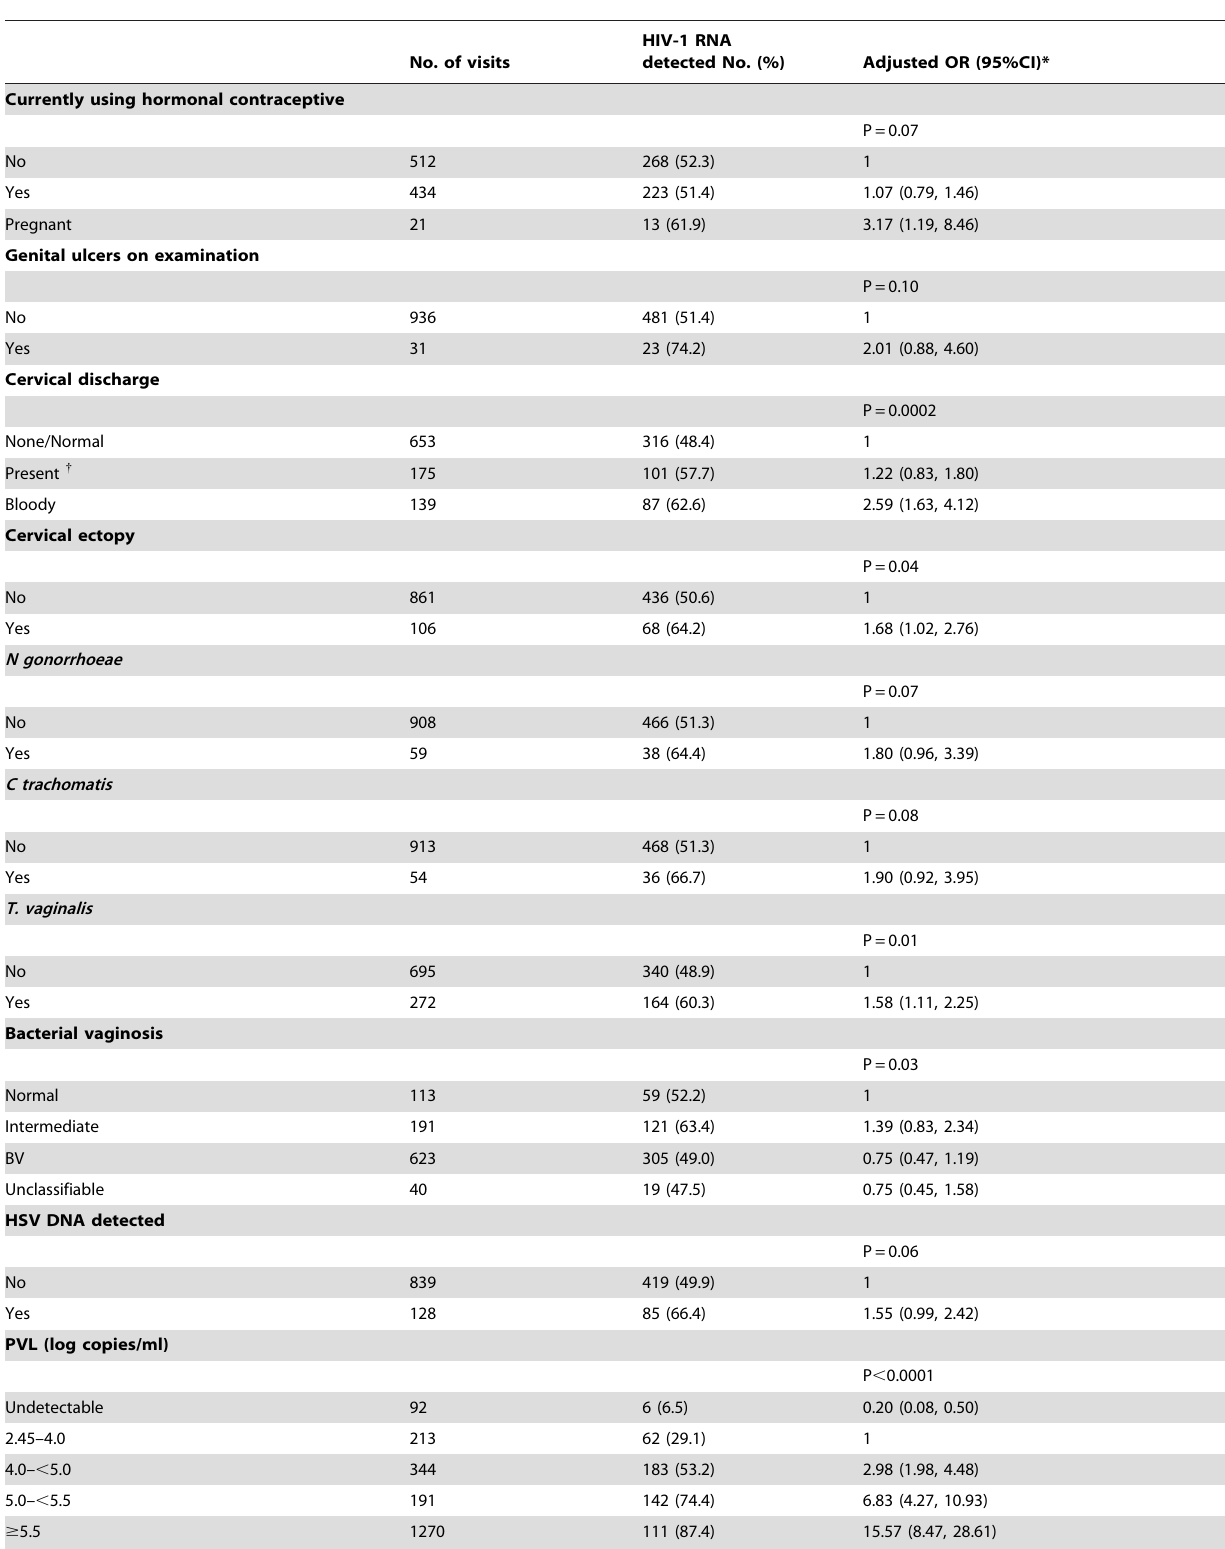
Table 4. Factors independently associated with cervico-vaginal HIV-1 RNA detection (in 482 women at 967 visits).